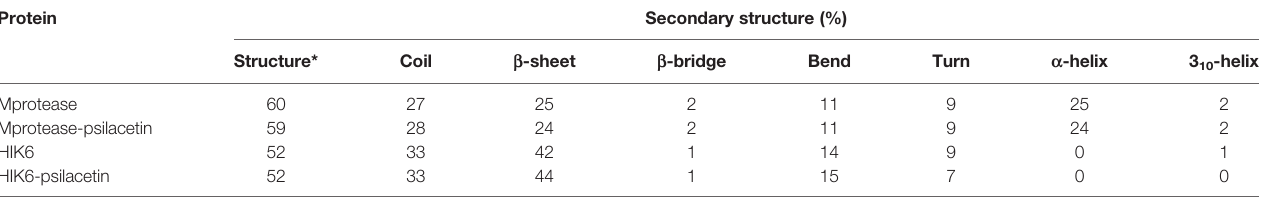
*Structure = a -helix + b -sheet + b -bridge + Turn.